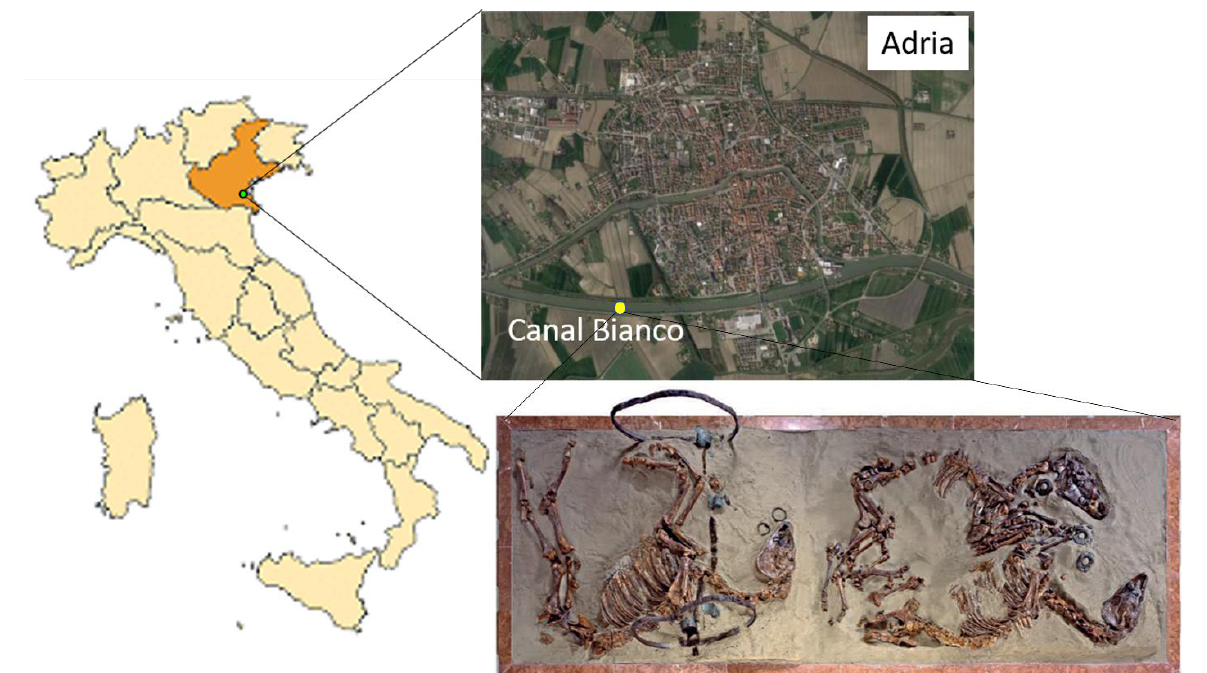
Figure 1. Map of the sampling site in the Canal Bianco in the south part of Adria city. Colored in yellow the specific area in which the Tomba della Biga was founded. Down a photo representing the Tomba della Biga collected and view from above [29].